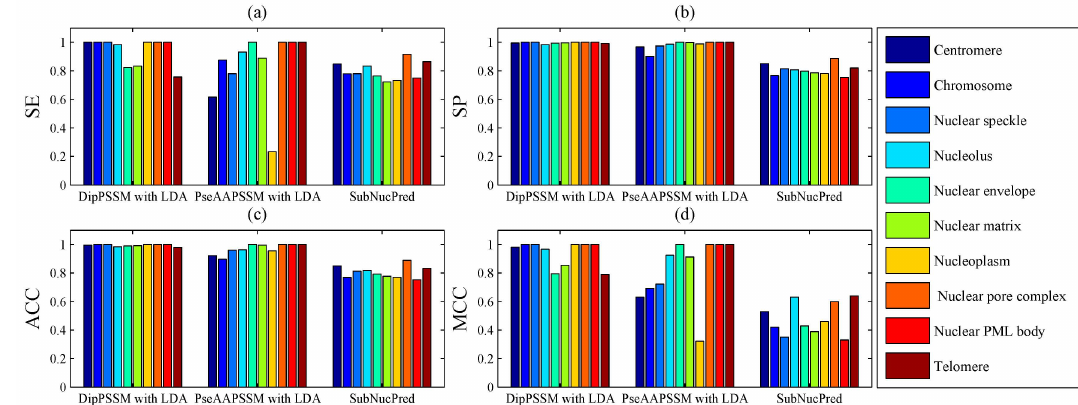
Figure 9. Comparison of our proposed methods with SubNucPred on Dataset 2: ( a ) Sensitivity (SE); ( b ) Specificity (SP); ( c ) Accuracy (ACC) and ( d ) Mathew’s Correlation Coeffcient